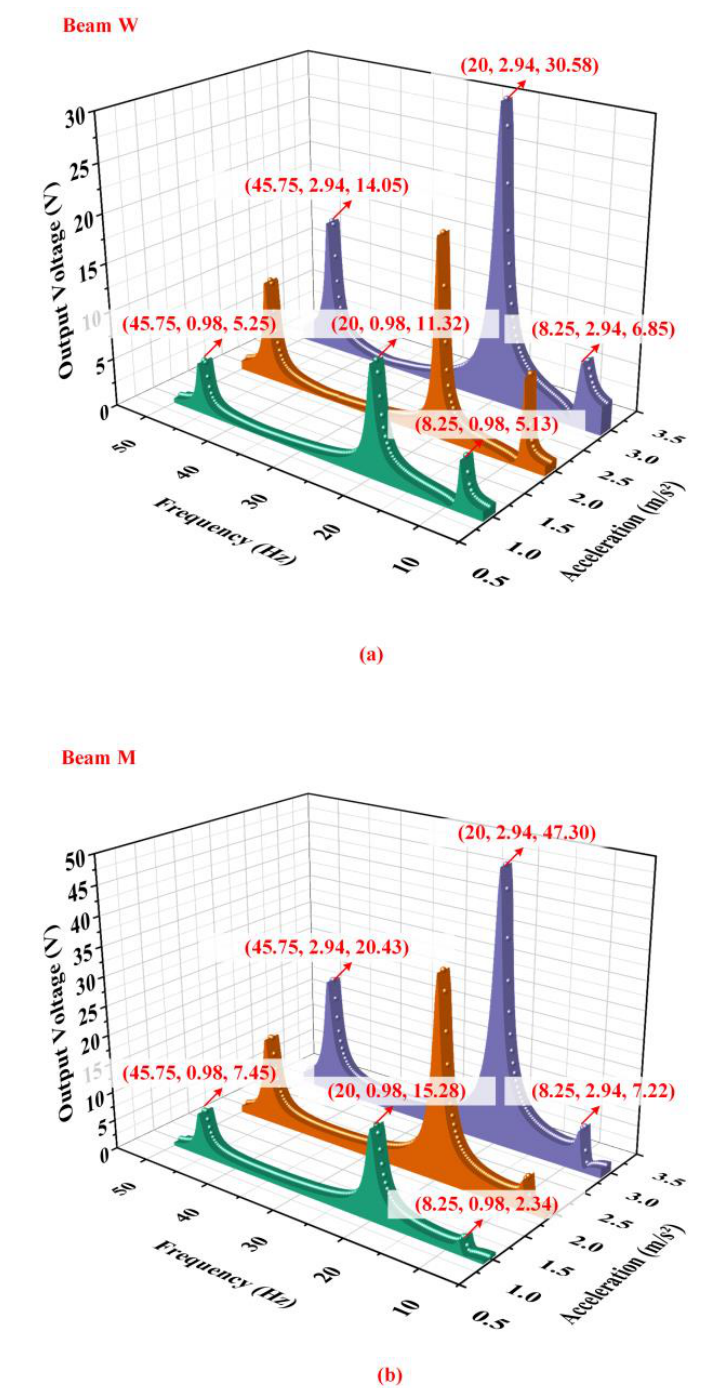
Figure 5. The output voltage of ( a ) beam M and ( b ) beam W with different accelerations obtained by simulation.